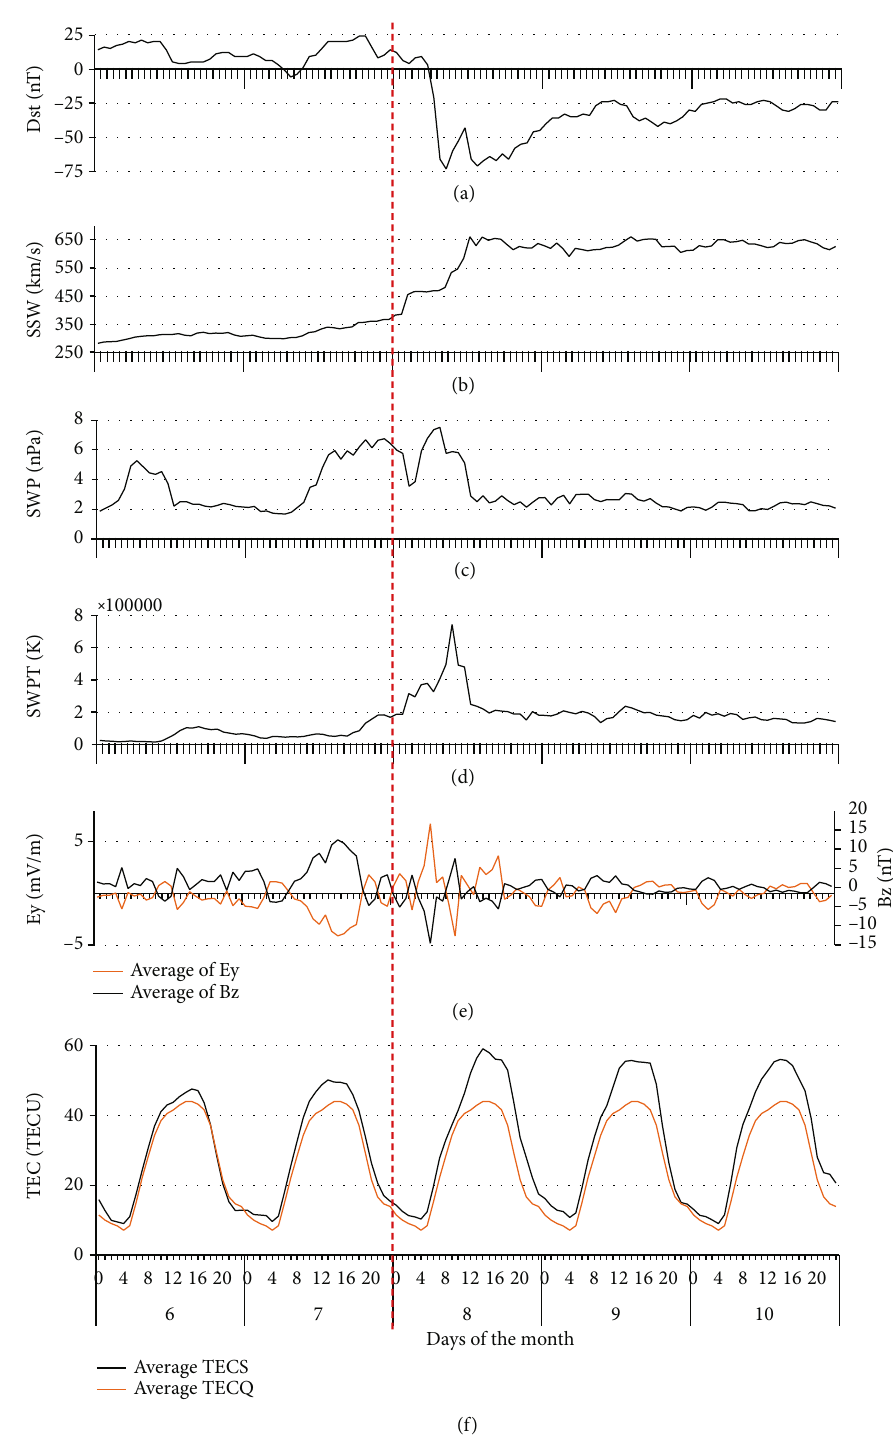
Figure 4: Variation of solar wind parameters and total electron content (TEC) from June 06 to 10, 2015, at the Koudougou GPS